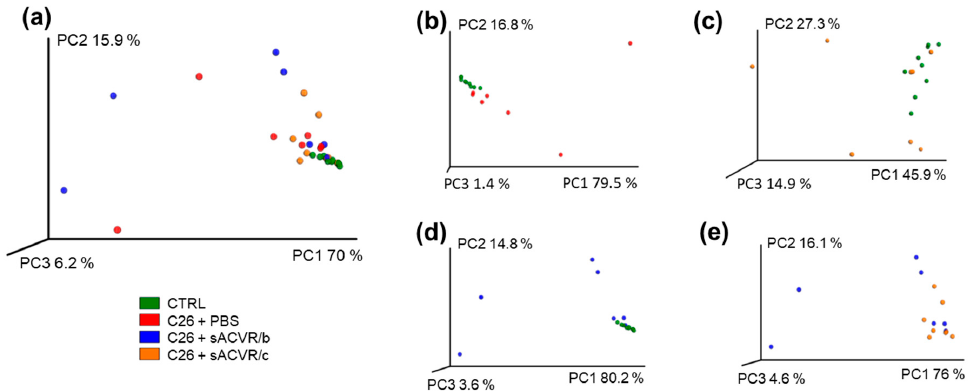
Figure 2. Beta-diversity of the mice microbiota samples. No clear differences were visually observed between the groups in principal component analysis (PCA) plot. ( a ) PCA plot of all groups; ( b ) PCA plot of groups CTRL and C26 + PBS; ( c ) PCA plot of groups CTRL and C26 + sACVR/c; ( d ) PCA plot of groups CTRL and C26 + sACVR/b; ( e ) PCA plot of groups C26 + sACVR/b and C26 + sACVR/c. Control (CTRL, n = 9), cancer (C26 + PBS, n = 7), the group that received sACVR2B until tumor formation (C26 + sACVR/b, n = 7), and the group that received sACVR2B until death (C26 + sACVR/c, n = 8).